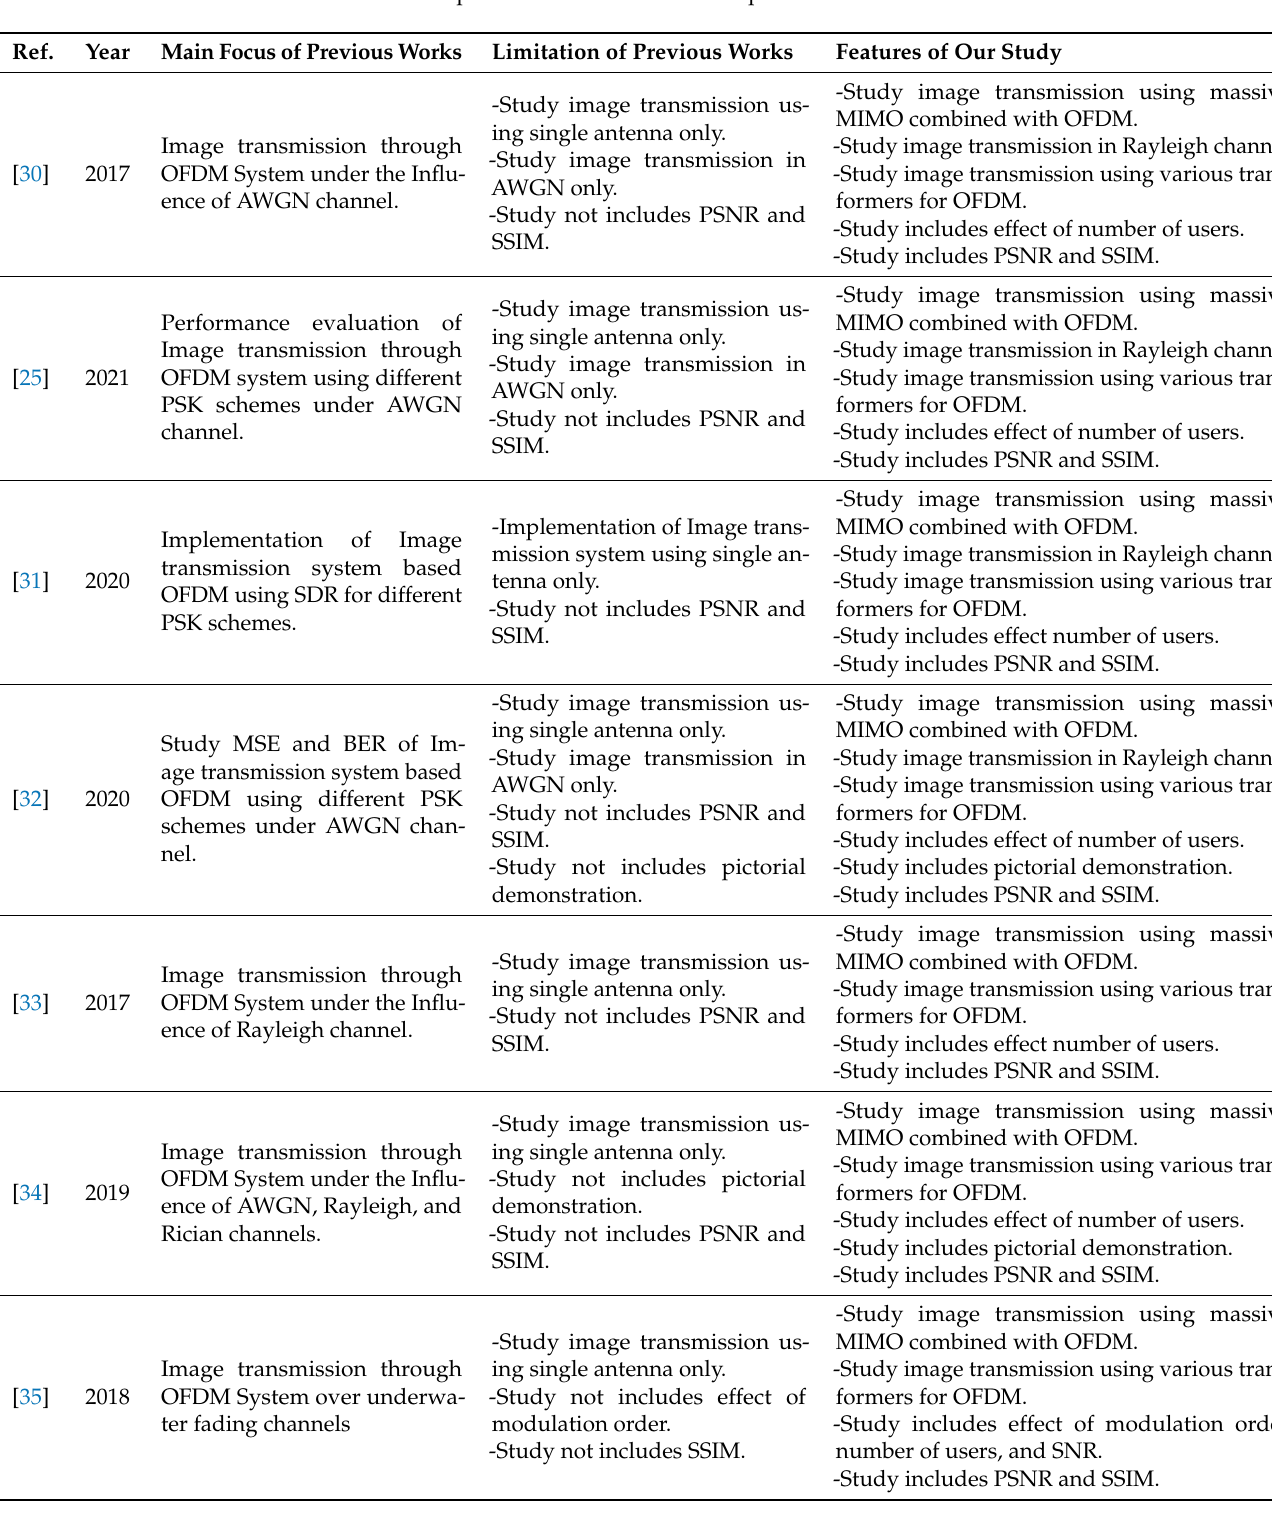
Table 1. Comparison of our work with the previous